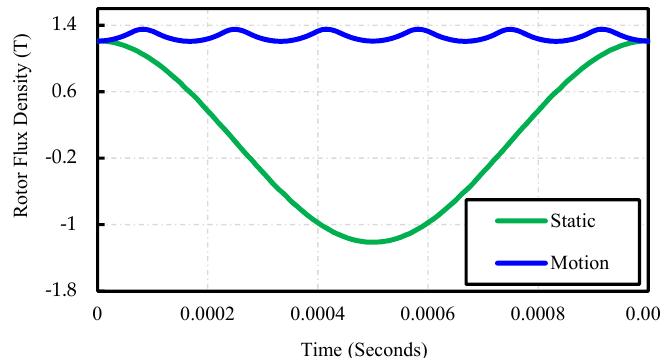
Figure 10. D Component of Rotor Flux Density at one point.